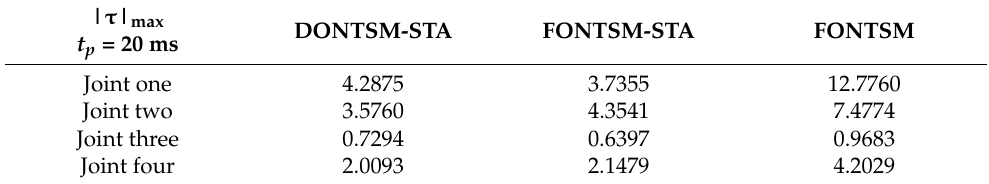
Table 8. The maximum amplitude of the low-cost humanoid manipulator control torque variations. | τ |